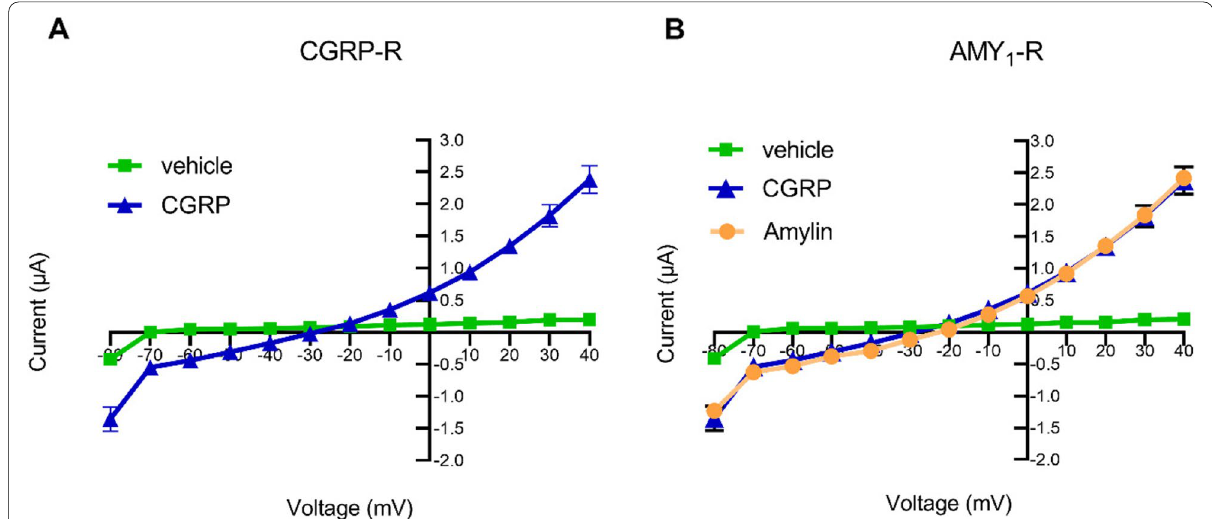
Fig. 2 Current voltage relationships for oocytes expressing A. CGRP‑R in the presence of 1 μM CGRP and vehicle and B . AMY 1 ‑R in the presence of 1 μM CGRP, 3 μM Amylin and vehicle. Currents were elicited by a voltage ramp from 80 to 40 mV in 10 mV increments (350 ms). Data is presented − as mean with standard error of mean ( SEM), n ± =